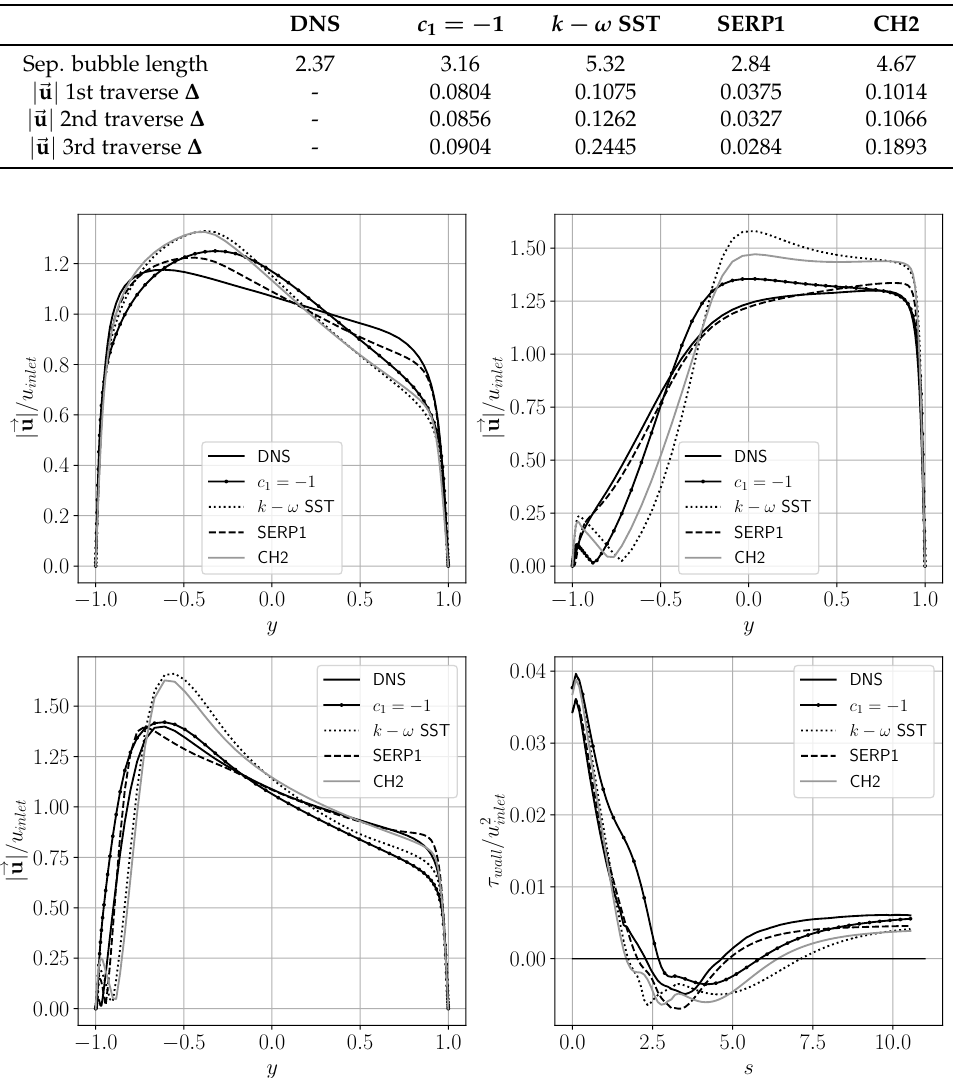
Figure 8. Velocity magnitude comparison at 3 different locations from upstream: top left, bottom left, top right (cfr. Figure 6) and wall shear stress along the second bend: bottom